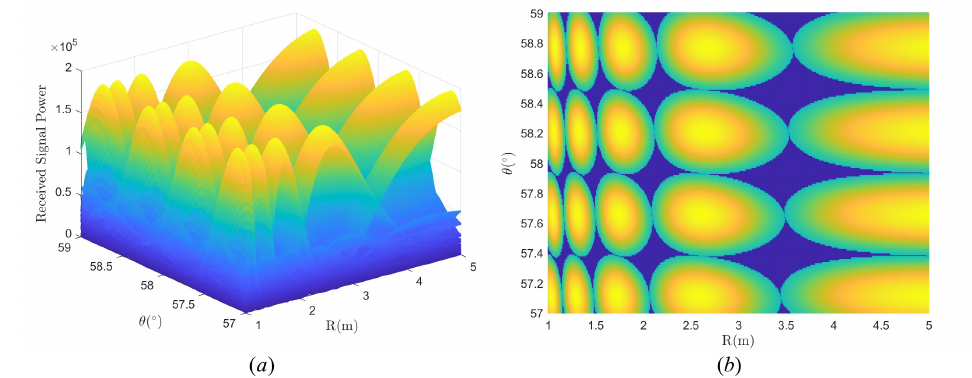
Figure 10. Examples of the beams in R − θ domain. ( a ) Full view by the proposed codebook. ( b ) Top view by the proposed